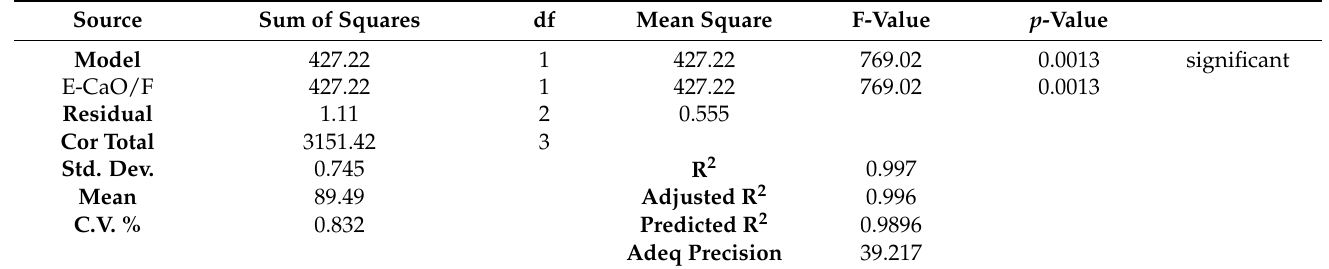
Table 7. ANOVA for the regression model of % CO 2 capture in the calcium looping